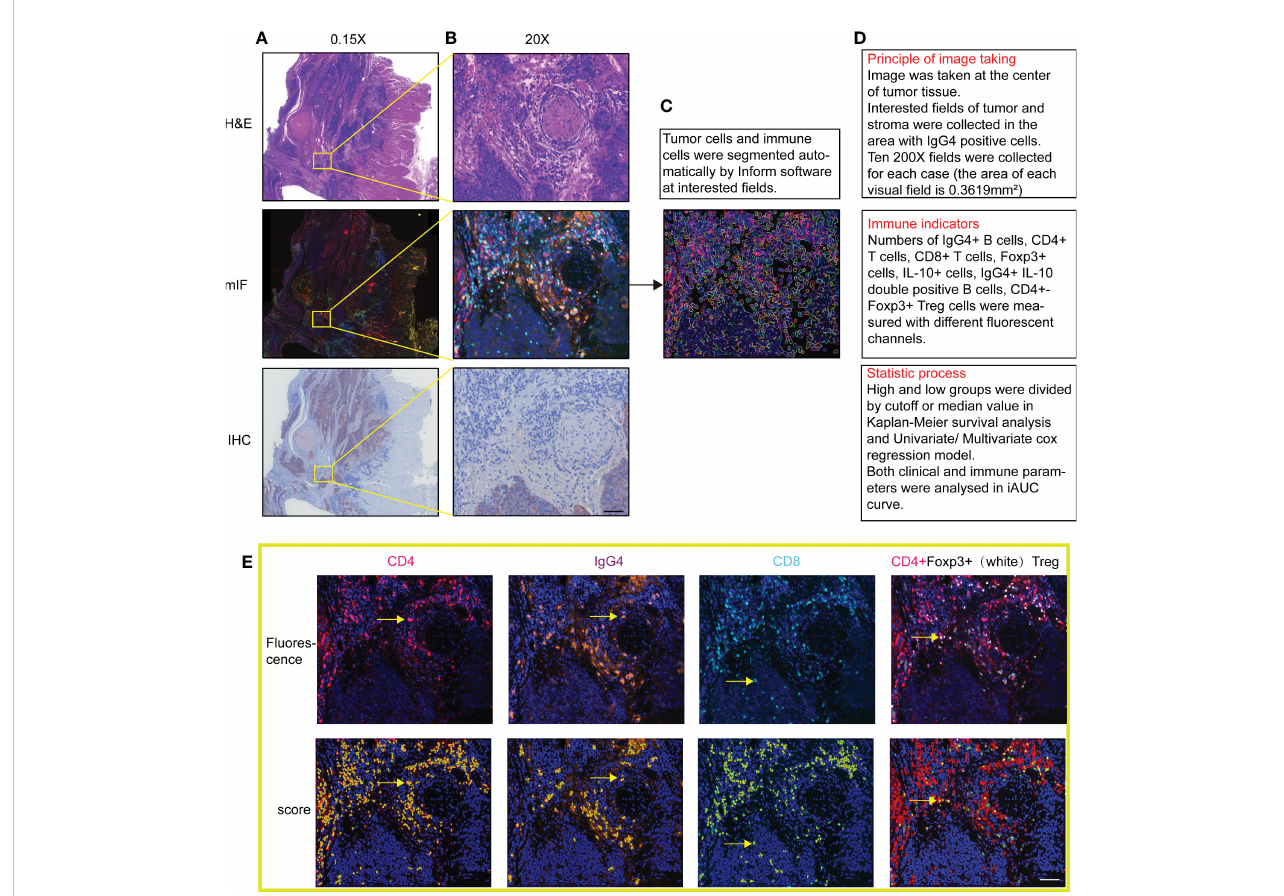
FIGURE 1 (A, B) Images of multi-color immuno fl uorescence staining with H&E staining and immunohistochemistry in 1.5X and 200X magni fi cation in image scanning software. (C) Cell nuclear and membrane automatically recognized with software in fl uorescence staining fi elds. (D) Three steps of drawing, counting and statistics with the software. (E) Shows both actual fl uorescent staining and automatic score of positive signals of the same fi elds. Positive counting shows in yellow by Inform software. Scale bar=60 m